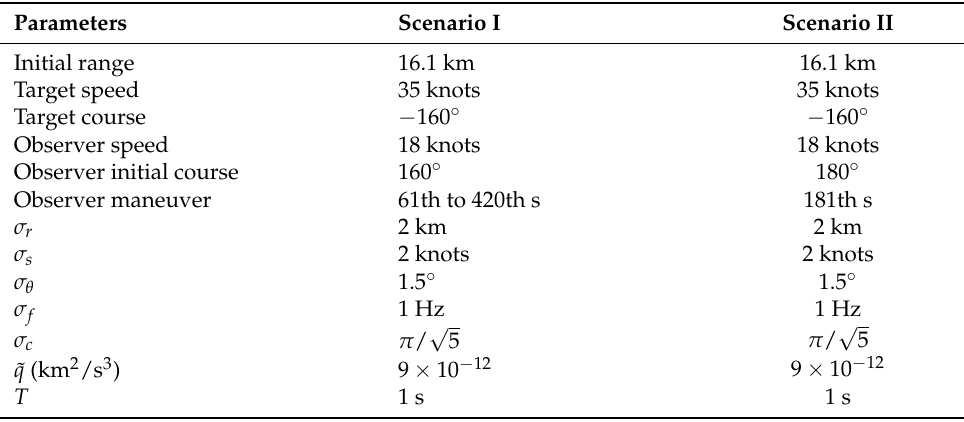
Figure 1. The tracking scenarios: ( a ) moderately nonlinear; ( b ) highly nonlinear. Table 2. Parameters used in tracking